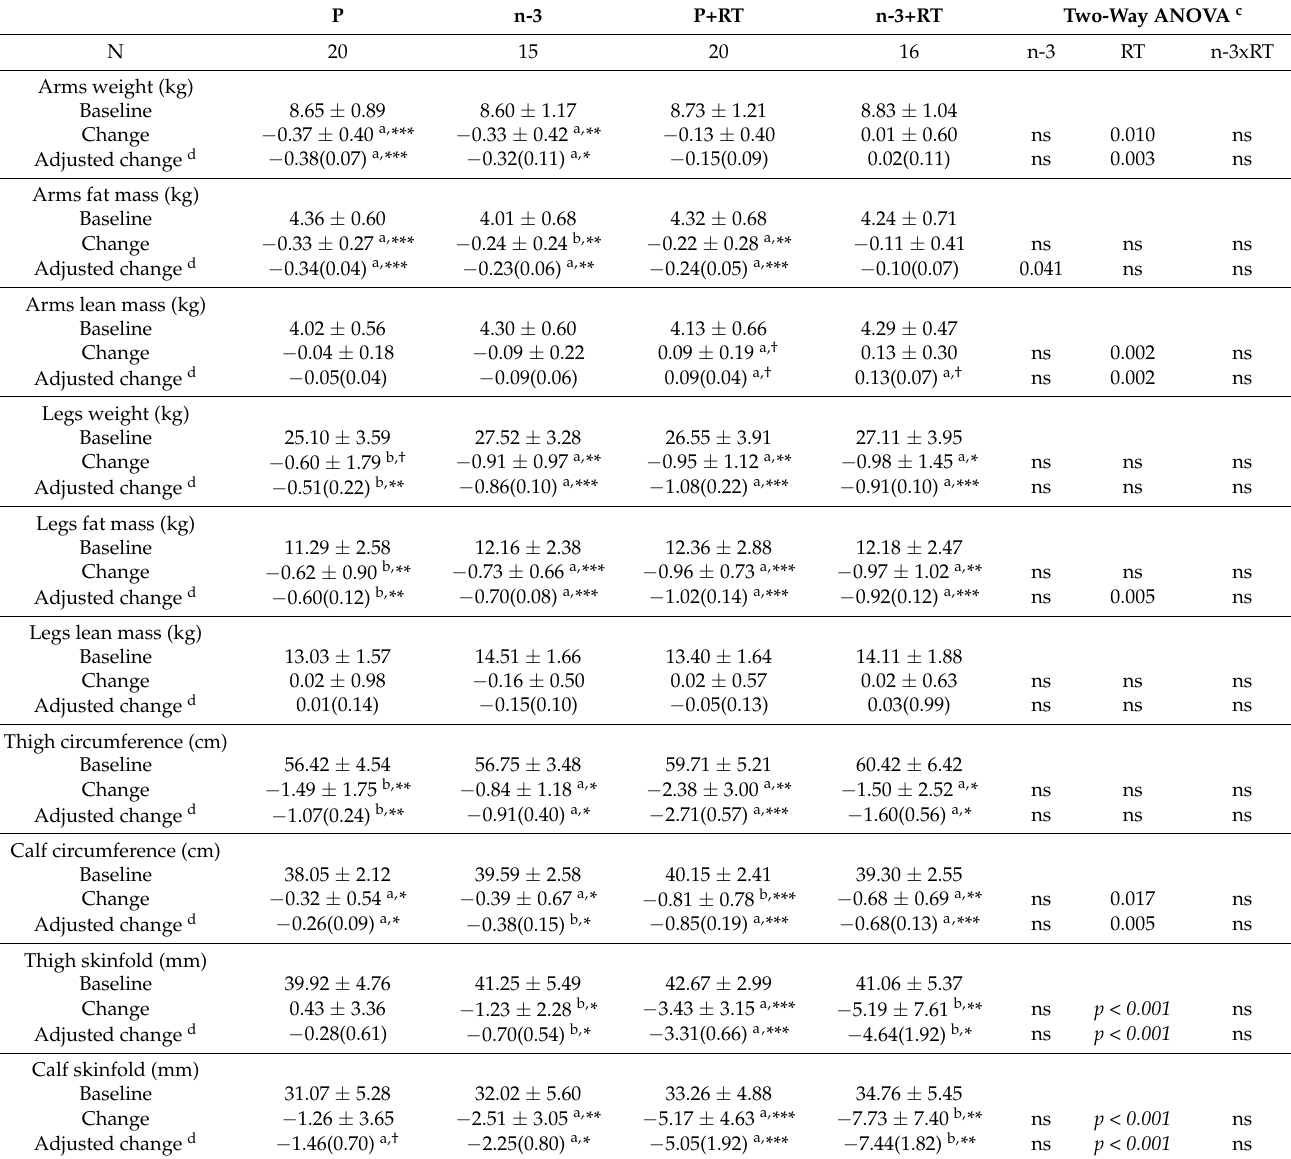
Table 2. Effects of 16 weeks of DHA-rich n-3 PUFA (n-3) supplementation and/or resistance training (RT) on segmented body composition and anthropometric measures in overweight/obese postmenopausal